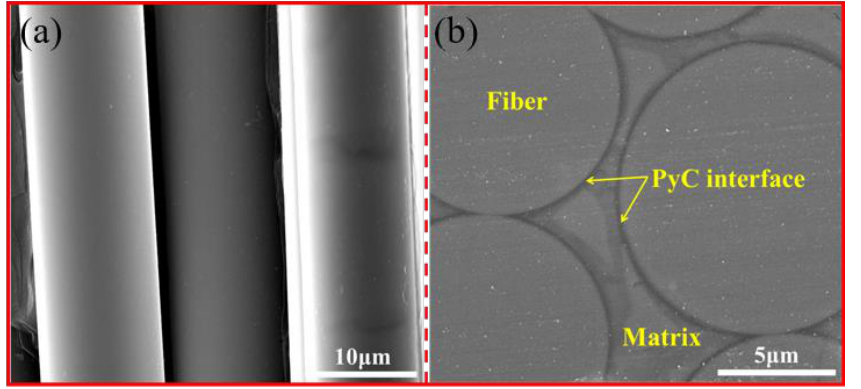
Figure 2. Microstructure morphologies of the as-prepared SiCf/SiCm composites. ( a ) warp direction and ( b ) weft direction.